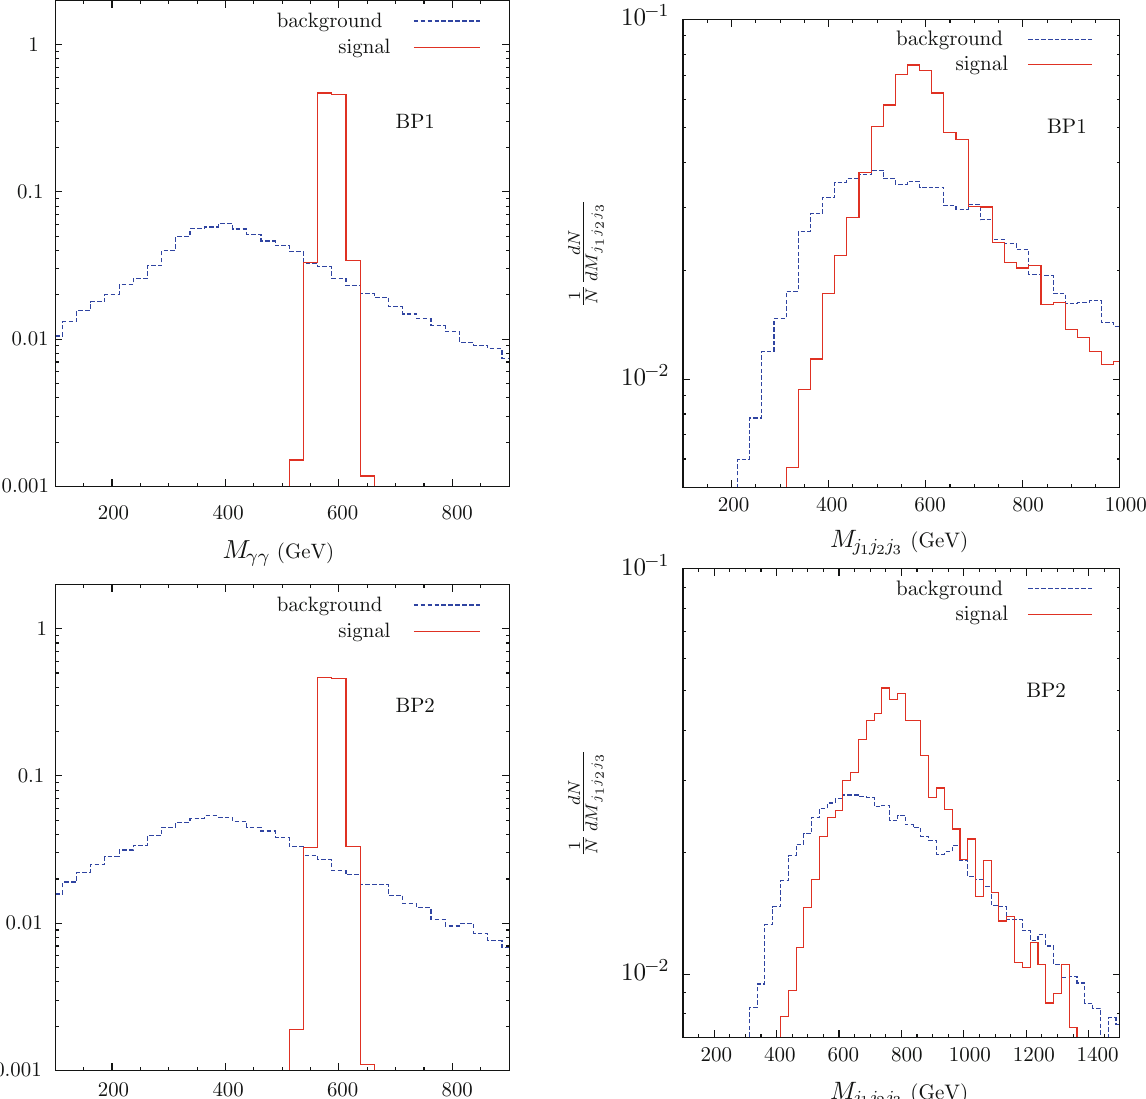
Fig. 5 The invariant mass distribution for the leading three jets for both benchmark scenarios BP1 and BP2 the jets coming from the decay of VLQ to s h j is equally hard as the ones that come from the decay of s h themselves. There- fore, for BP2, the averaging is done including all jets with p T > 40 GeV. We plot their normalized distribution after averaging for both signal and background in Fig. 6. As the diphoton coming from the s h decay marks a kinematic edge in the distribution, this can be clearly seen to happen at the mass value of s h at 600 GeV for both BP1 and BP2 which is absent for the invariant mass distribution in the 3 j hadronic channel. In addition, a much cleaner and distinct peak can be observed for the VLQ mass for BP2. In the case of BP1, as the VLQ mass at 640 GeV is quite close to the scalar s h mass of 600 GeV, resolving the VLQ (although visible)